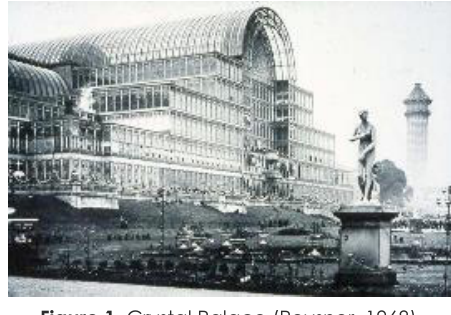
Figure 1. Crystal Palace (Pevsner, 1968).